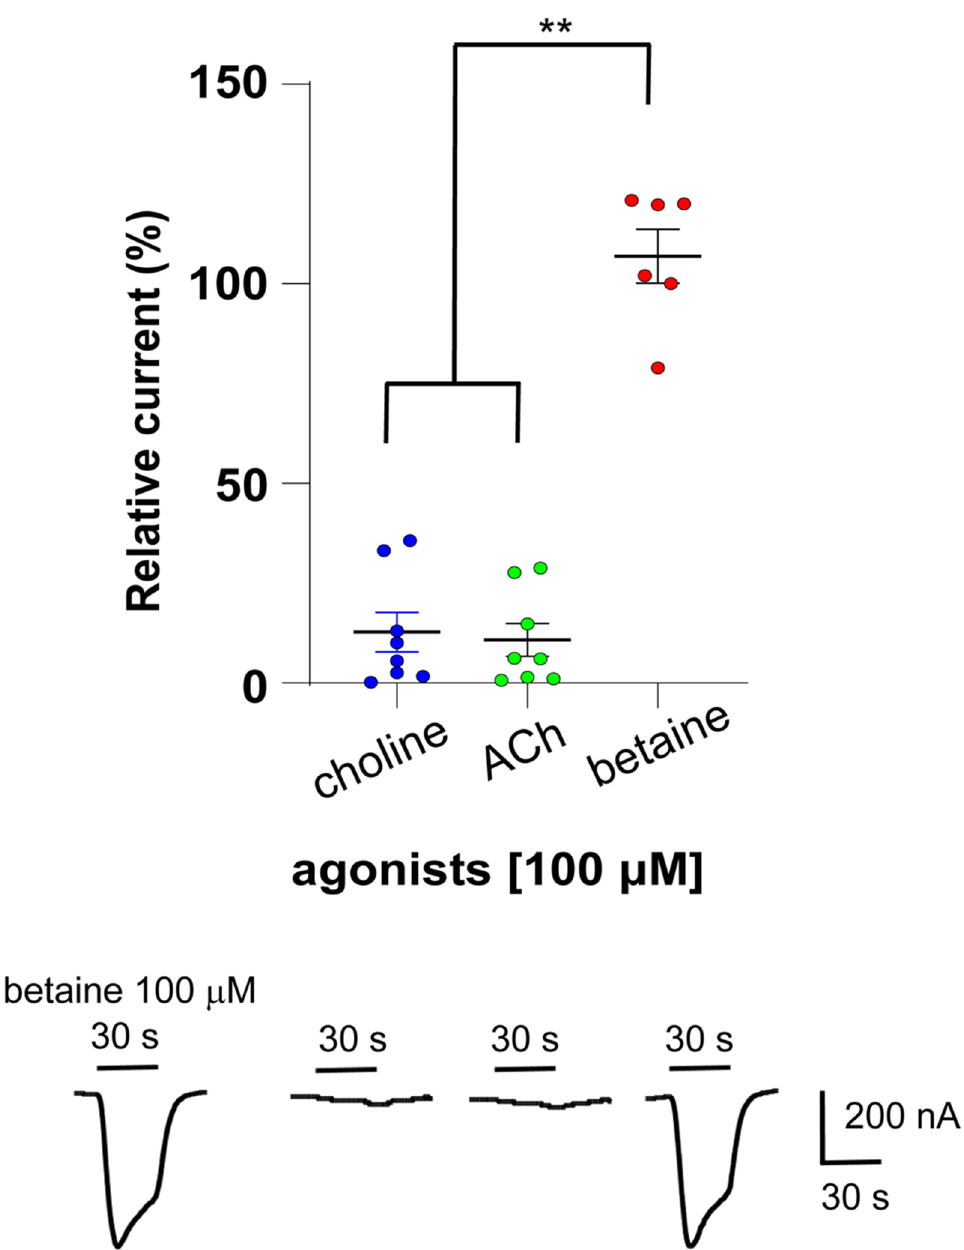
Figure 1. Effect of agonists on the Cel- DEG-3/DES-2 channel. A scatter dot plot and representative traces show the rank order efficacy in nA of ACh, choline and betaine. Current responses are normalized to 100 µ M betaine-elicited currents and given as mean ± SEM ( n = 6–8), ** p < 0.002. The perfusion time of each compound was 30 s as indicated with short bars above the traces.